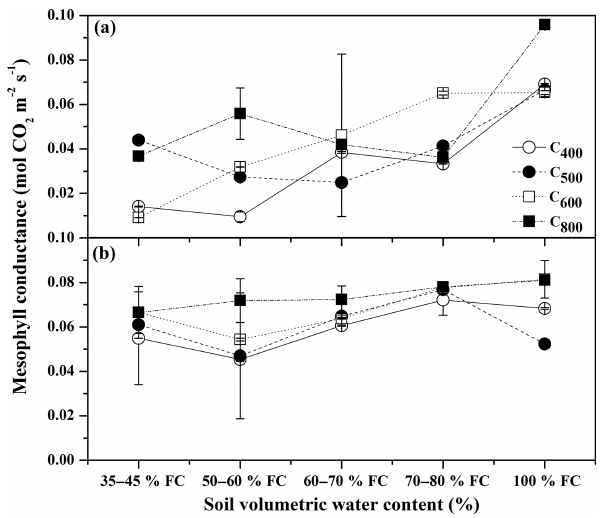
Figure 7. Regressions between stomatal conductance and total 13 C fractionation in P. orientalis (a) and Q. variabilis (b) for four CO 2 concentration × five soil volumetric water content treatments ( p <0.01, n = 32).